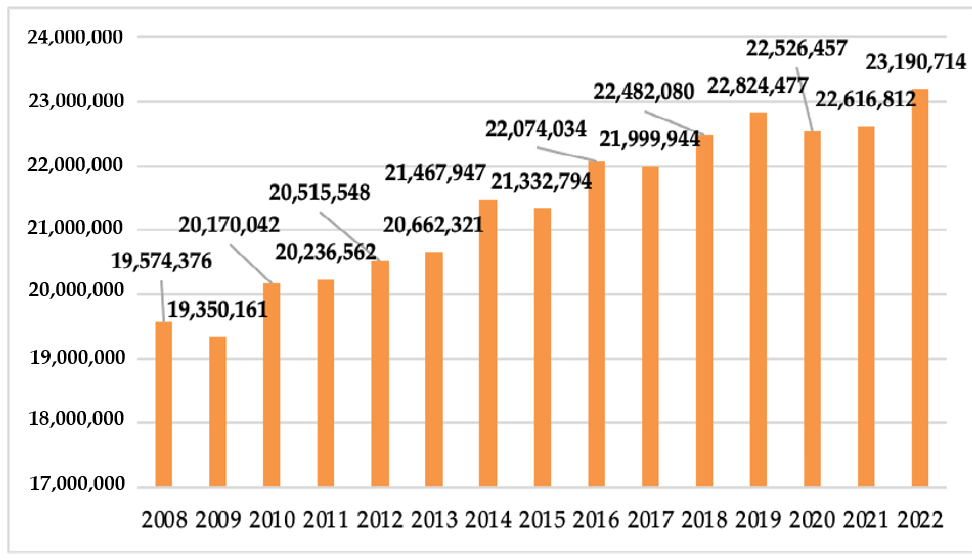
Figure 3. Number of SMEs in the European Union (EU27) from 2008 to 2022. Source: Authors’ com- pilation.